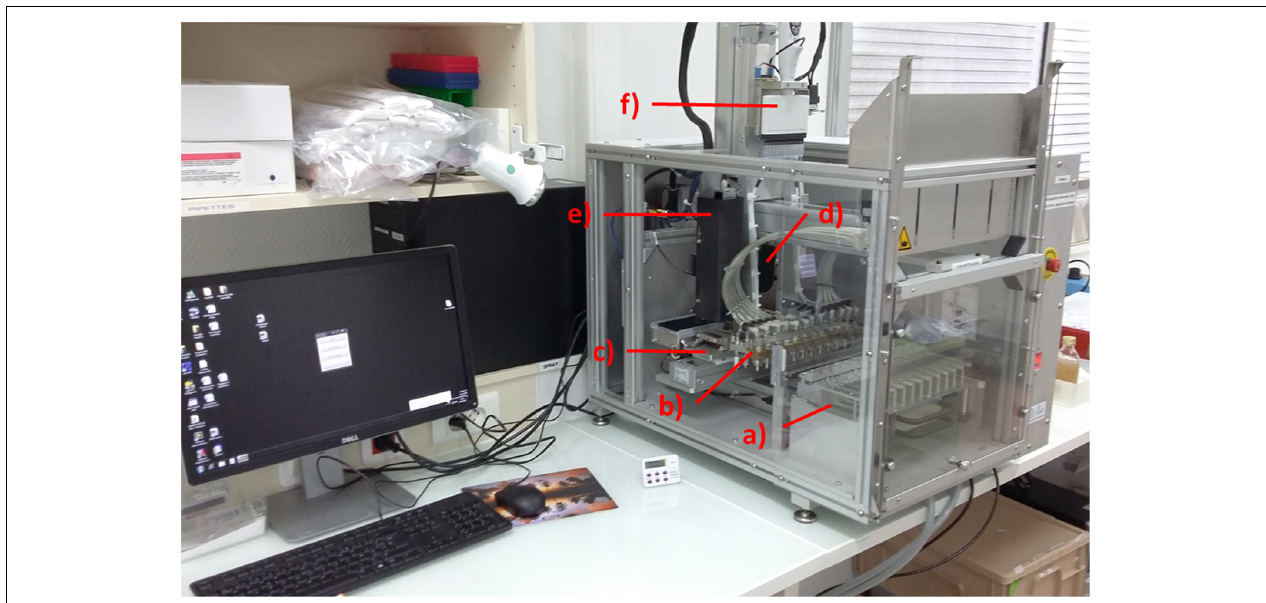
FIGURE 2 | Blood Culture Sample Preparation (BCSP) prototype with the description of the different sub-systems: (a) prepared rack; (b) pipetting tips and filter wand plate holder; (c) MALDI-TOF MS slide holder including formic acid (FA)/ α -cyano-4-hydroxycinnamic acid (CHCA) reagents, 96 tips rack and waste; (d) Cavro R (cid:13) air displacement pipettor from Tecan for FA and CHCA matrix dispensing; (e) MALDI-TOF MS spot imaging sub-system including LED illumination; and (f) 12-channel electronic pipette (lysis buffer